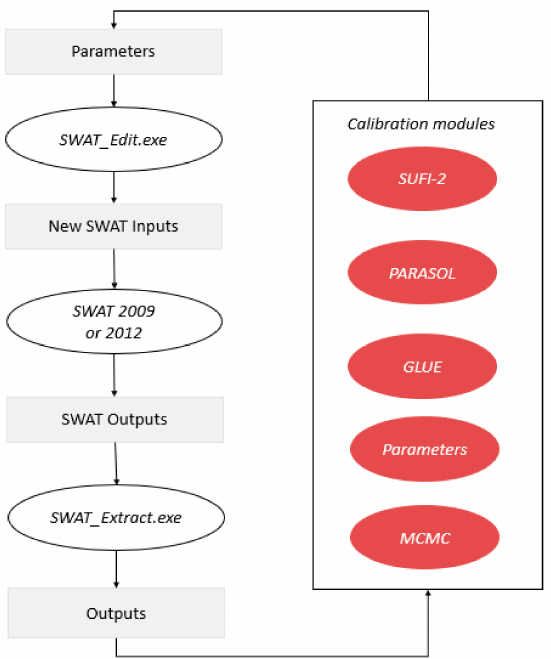
Figure 3. Overview of Soil and Water Assessment Tool -Calibration and Uncertainty Programs (SWAT-CUP) for automated calibration of SWAT